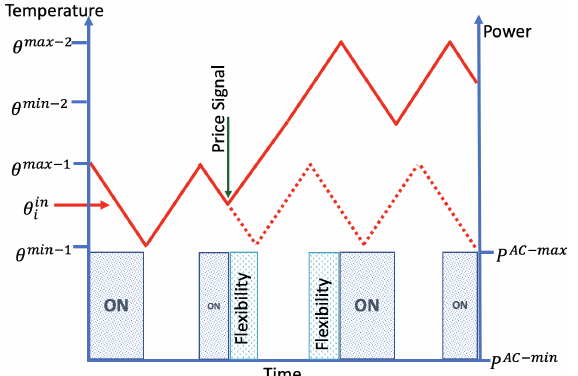
Figure 4. Load Management—Flexibility